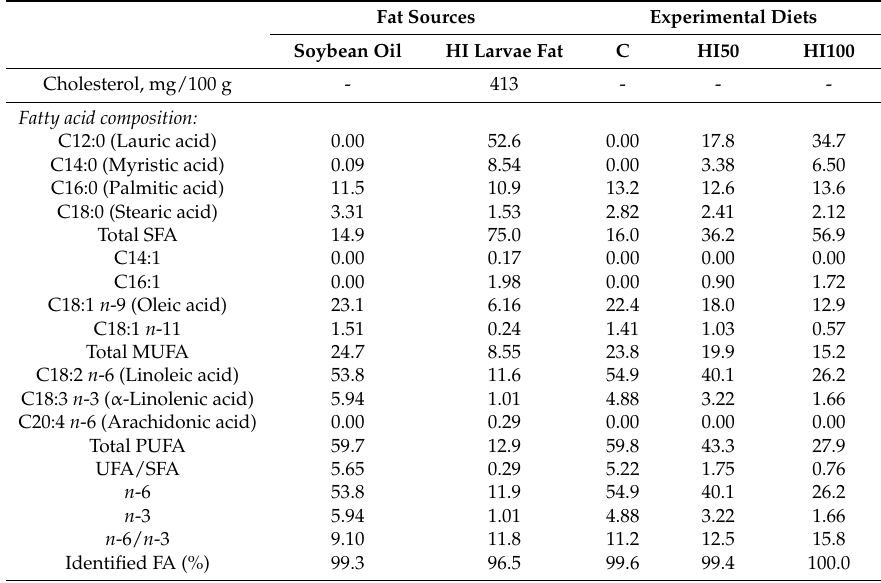
Table 1. Cholesterol content of the Hermetia illucens (HI) larvae fat and fatty acid profile (% of total FAME) of the HI larvae fat, soybean oil and experimental diets with 0% (Control, C), 50% (HI50) and 100% (HI00) substitution of soybean oil with HI larvae fat. Fat Sources Experimental Diets Soybean Oil HI Larvae Fat C HI50 HI100 Cholesterol, mg/100 g - 413 - - -